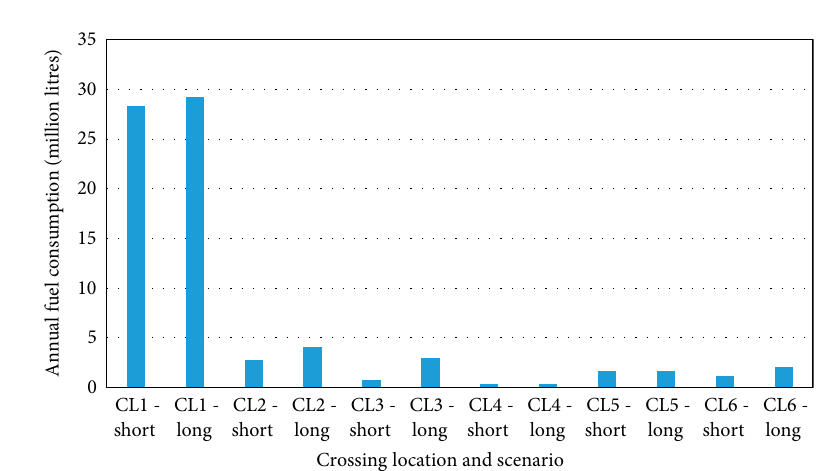
Figure 8: Annual fuel consumption for each